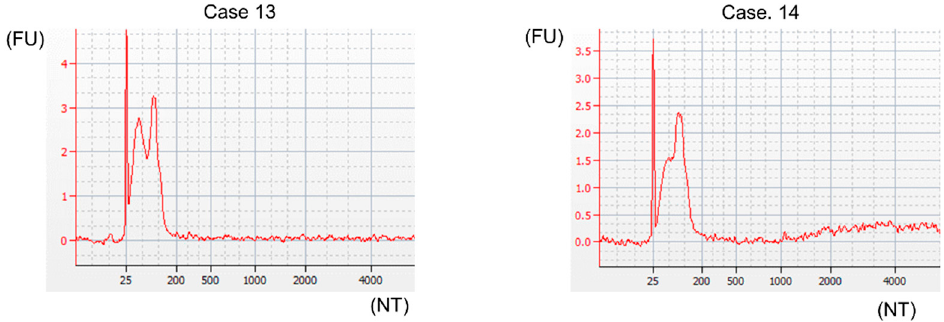
Figure 5. EVs from GJ contained miRNAs as genes. Characterization of RNA in EVs from GJ by Bioanalyzer. Four cases (cases 13–16) of EVs from GJ were examined. Representative graphs of two cases (cases 13 and 14) are shown. Table 2. Data from the Agilent 2100 Bioanalyzer using the RNA 6000 Pico Kit.